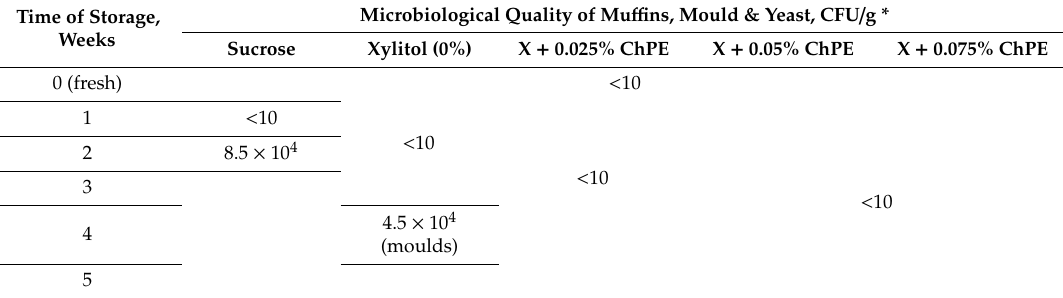
Table 3. Results of microbiological analysis of mu ffi ns, fresh and